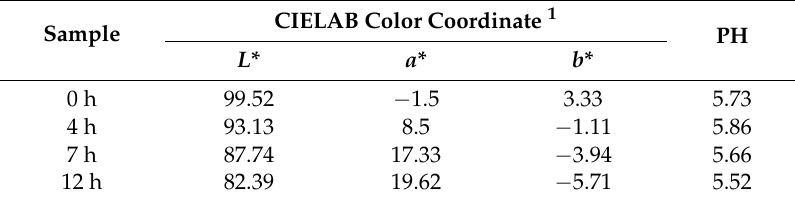
Figure 3. Chemical structure of the components of Oenothera petals. Table 1. Color parameters and pH of Oenothera tetraptera petals during senescence.